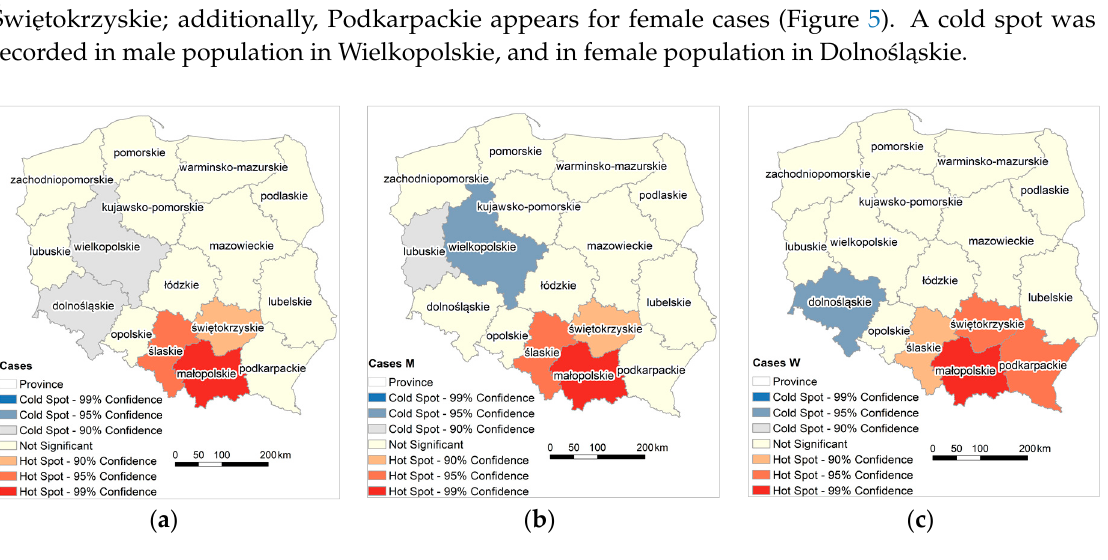
Figure 5. Hot spot analysis of MM morbidity rate in provinces ( a ) cases all; ( b ) cases M; ( c ) cases W.